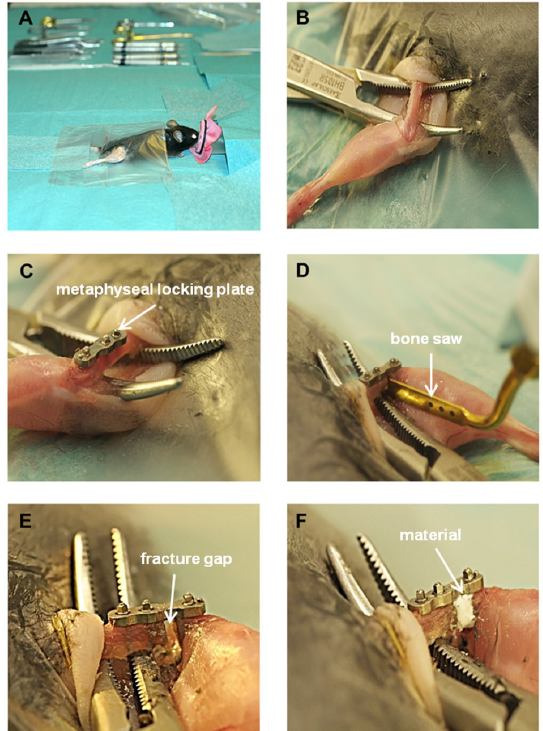
Figure 8. Phases of the surgical approach. ( A ) anesthetized mouse on the operating table, ( B ) exposure of the femur, ( C ) attached metaphyseal locking plate, ( D ) process of osteotomy, ( E ) 1.2 mm fracture gap after osteotomy, ( F ) implanted paste-like cement/MBG composite. White arrows in images C, D, E and F point at the metaphyseal locking plate, bone saw, fracture gap and material, respectively.